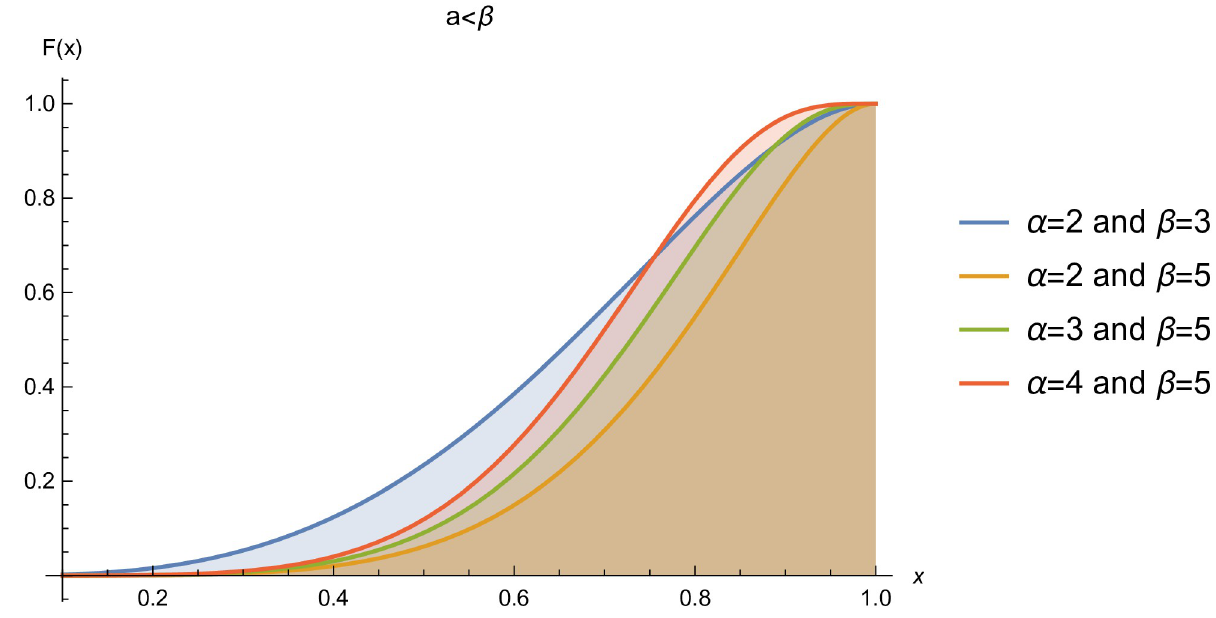
Fig 5. cdf of Kum ( α , β ), when α < β .